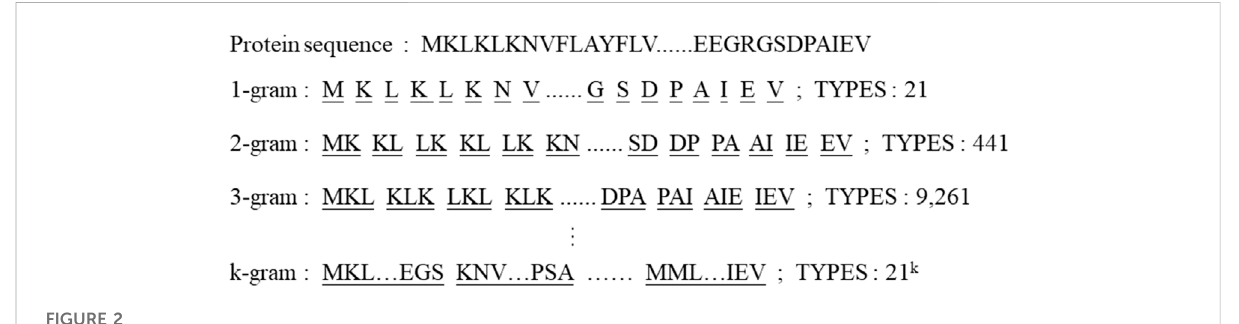
FIGURE 2 An overview of sliding window division method and types of strings of k-gram.